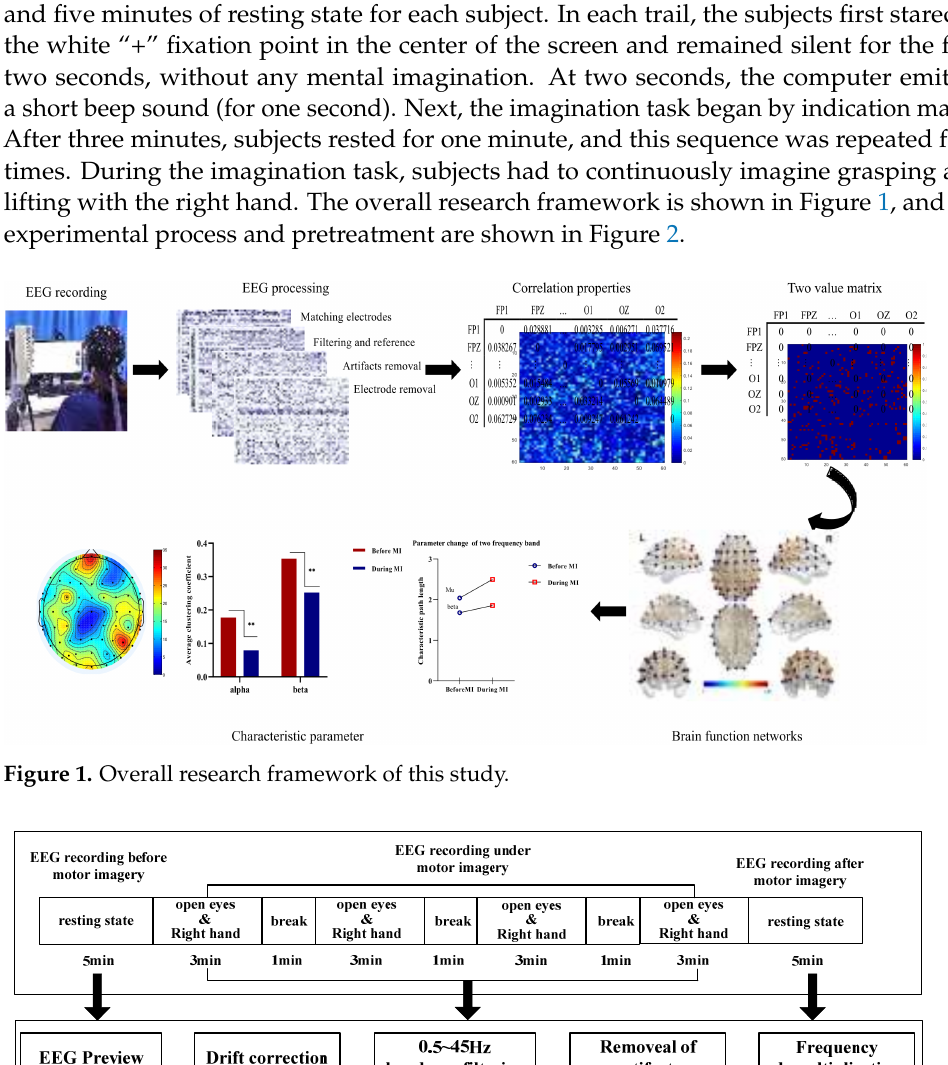
Table 1. Basic information on subjects.